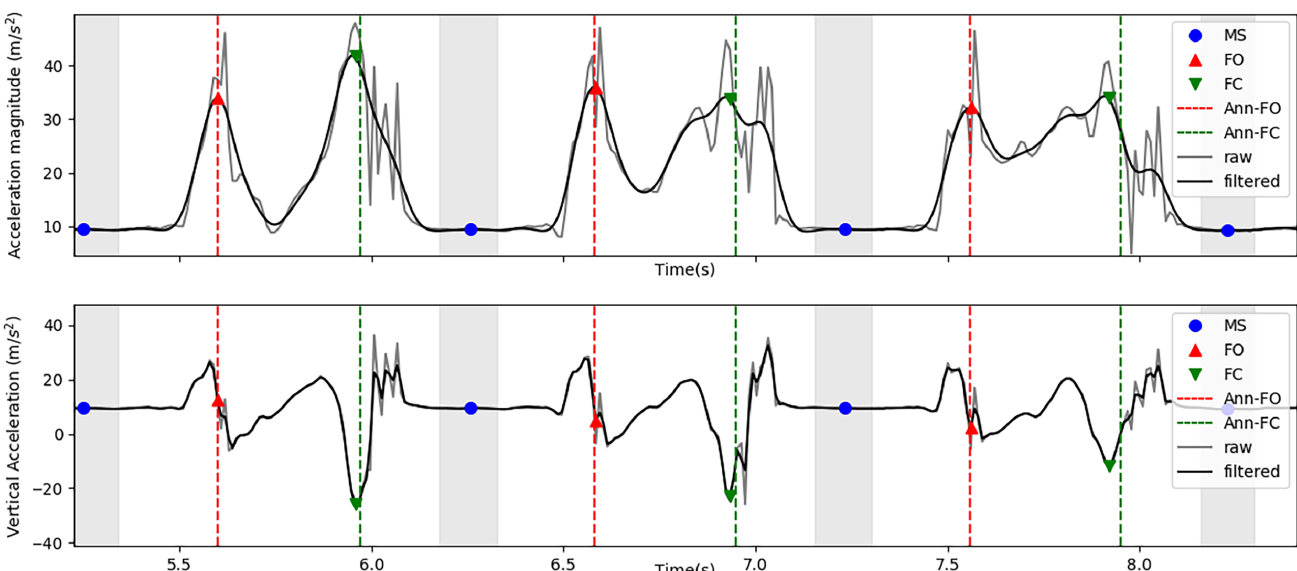
Figure 3. Events detection from low pass filtered acceleration magnitude and low pass filtered vertical acceleration ( FO —Foot off; FC —Initial foot contact; MS —Mid-stance; Ann-FO —Annotated FO; Ann-FC —Annotated